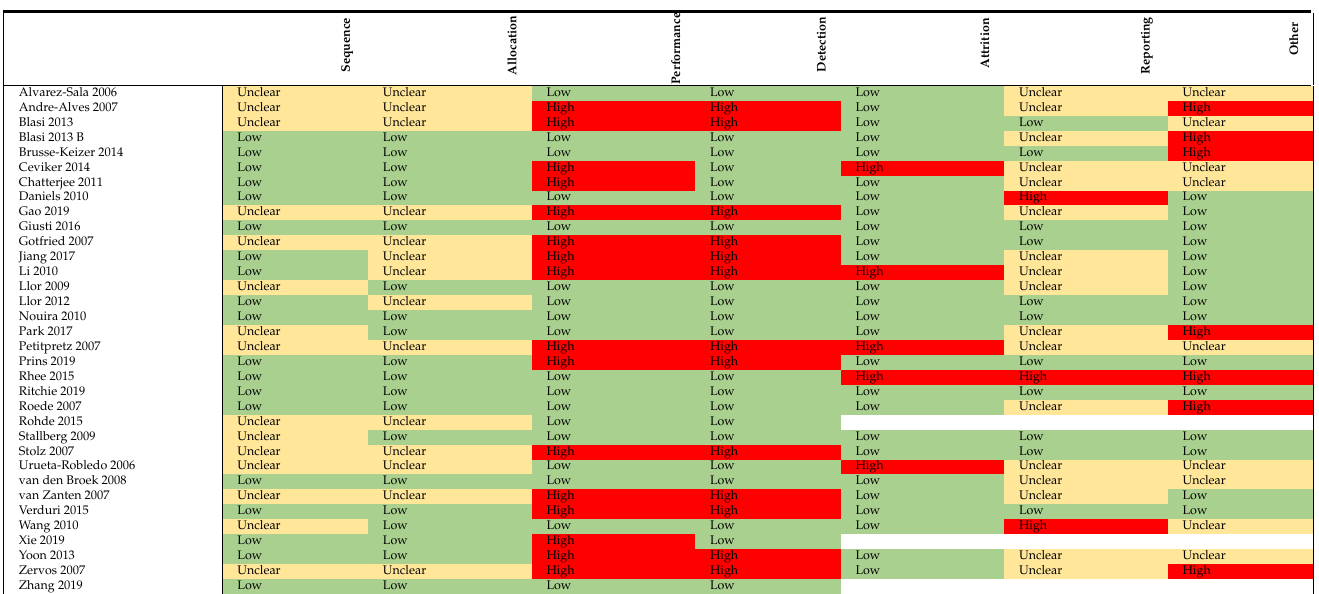
Table 4. Risk of bias of RCTs reporting descriptive